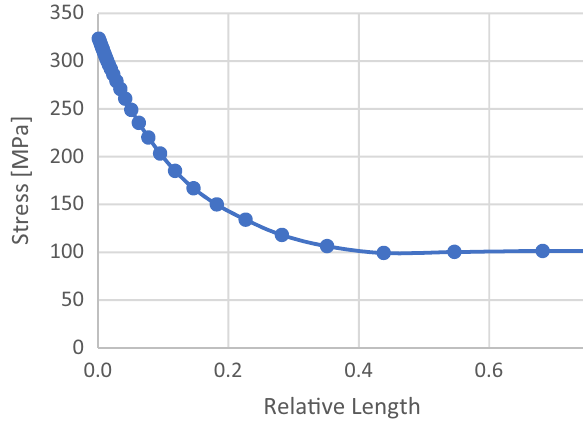
Fig. 7 Curve fit of stress profile